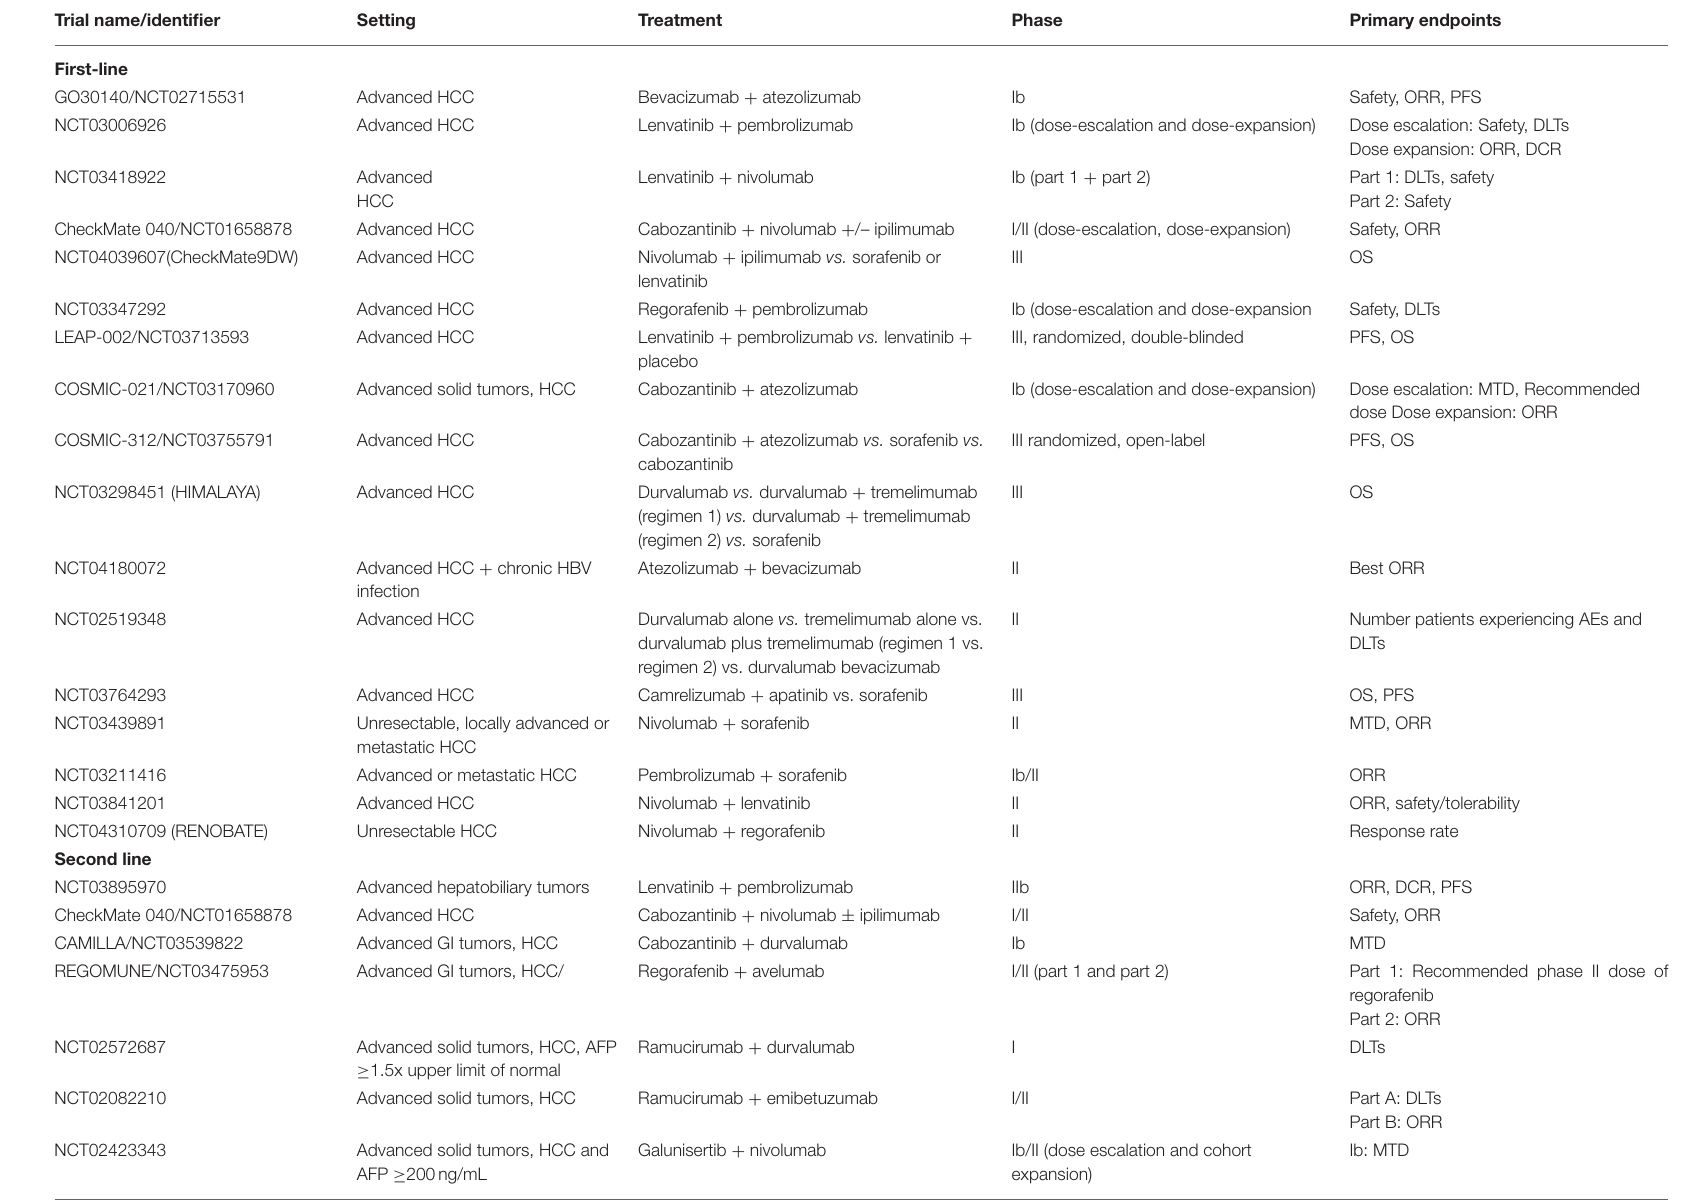
TABLE 1 | Emerging immunotherapy combinations for the treatment of hepatocellular